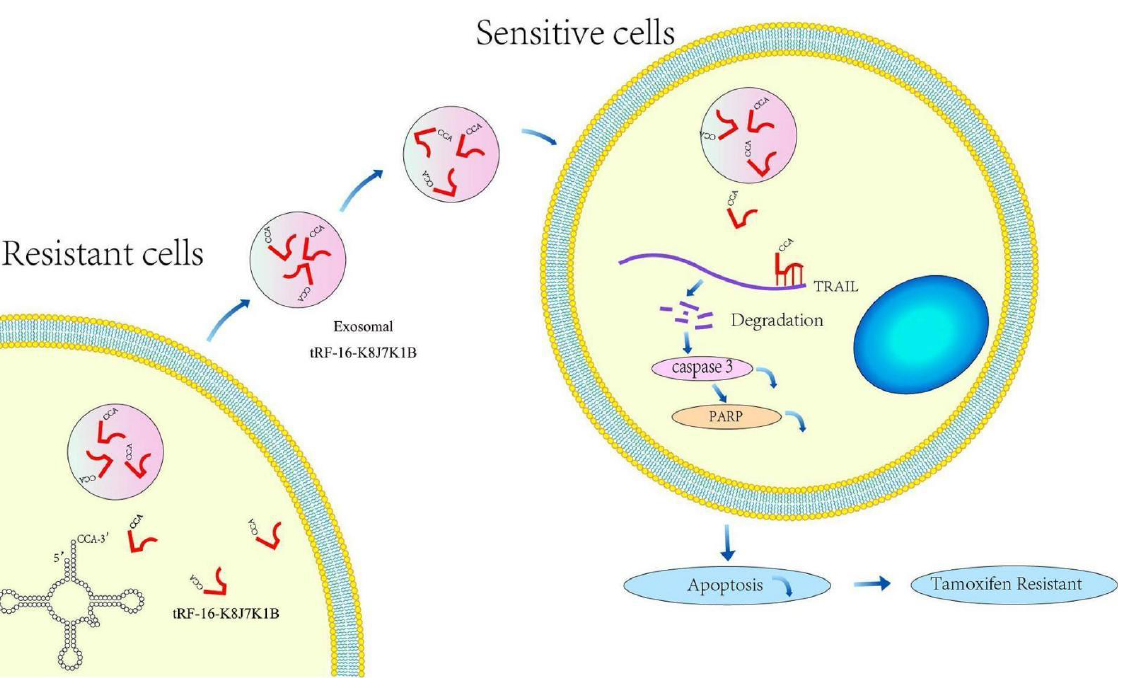
Figure 7. Schematic diagram of the proposed mechanisms. tRF-16-K8J7K1B was upregulated in tamoxifen-resistant BC cells and could be taken up by tamoxifen-sensitive cells via encapsulation into exosomes. Exosomal tRF-16-K8J7K1B promotes tamoxifen resistance by degrading TRAIL mRNA, leading to decreased expression of pro-apoptotic proteins caspase 3 and PARP in recipient